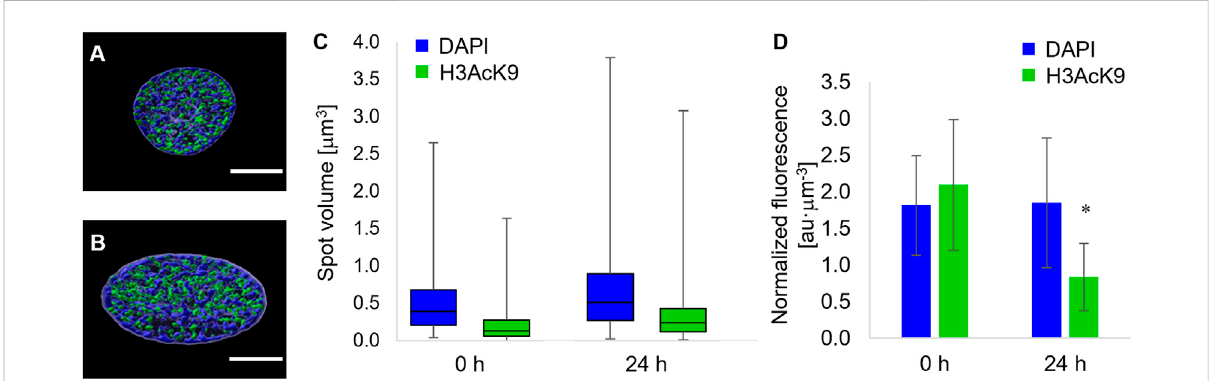
FIGURE 5 Fluorescenceimages of equatorial cross sections of nuclei of cellscultivated on (A) fl atpDR1msubstrates or (B) 24 hafter theinscription ofthe topographic pattern. DAPI-rich spots are in blue, and H3K9Ac-rich spots are in green. Bar is 5 μ m. (C) Box-and-whiskers plot of the volumes of the DAPI (blue) or H3K9Ac (green) spots. (D) Bar chart of the overall fl uorescence intensity of the DAPI or (D) H3K9Ac signal. Asterisk indicates a signi fi cant difference with respect to the 0 h case.